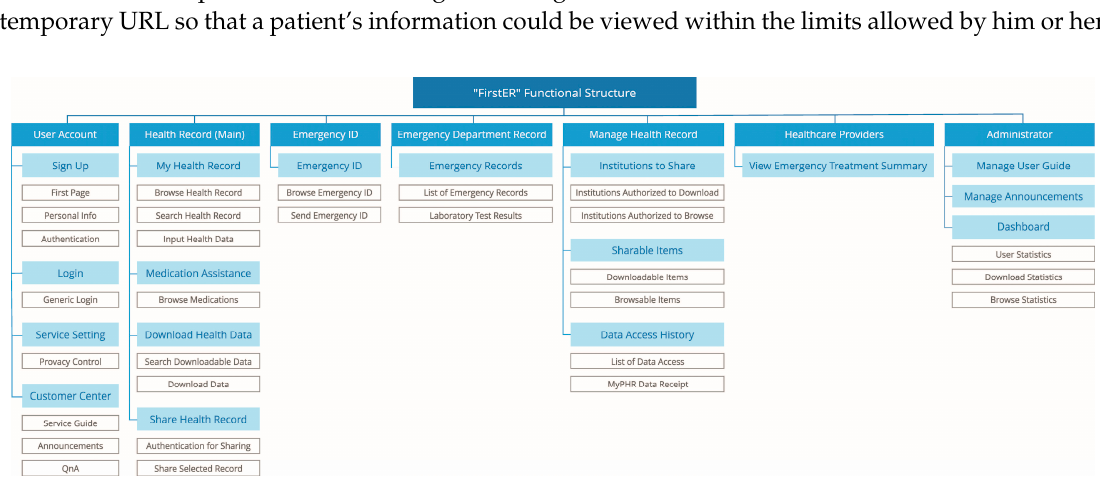
Table 2. Extraction and standardization of the most frequent laboratory examinations.